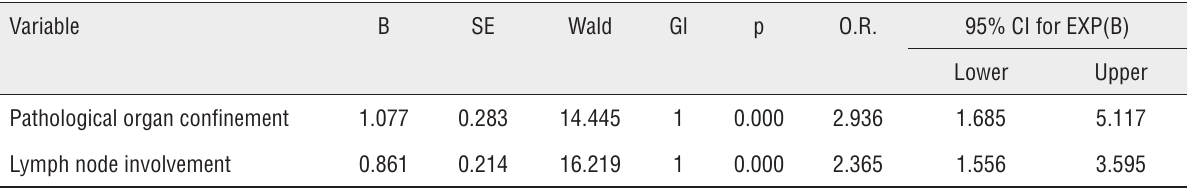
Table 4 - Multivariate analysis. Predictive model for PFS. Variable B SE